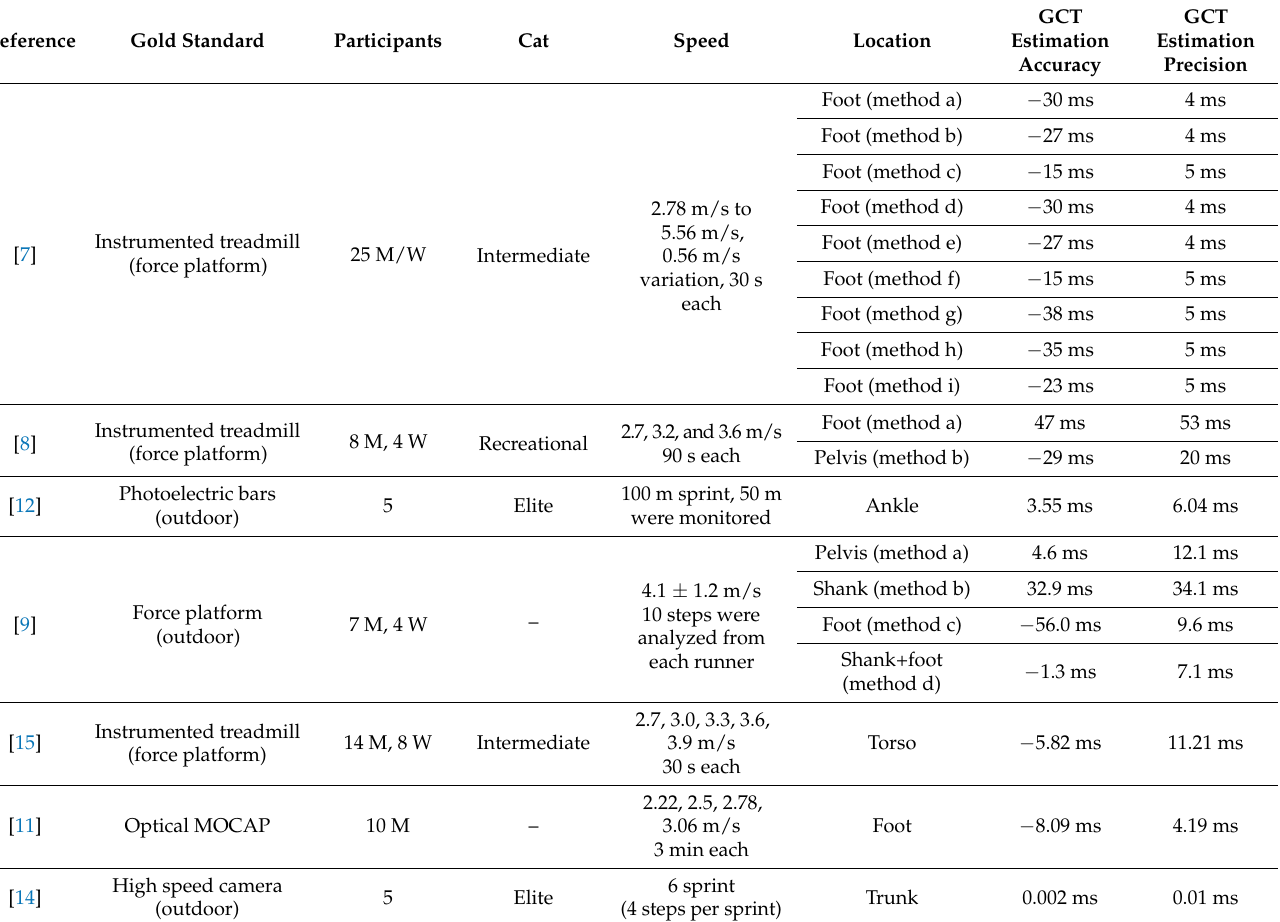
Table 1. Systematic search results. From left to right: reference, gold standard method used for validation of estimated GCT, number of participants (M: men, W: women), category of runners (recreational, elite, intermediate), speeds considered in the experiments, location of the sensor (different methods were addressed in some works from a single sensor), accuracy and precision of estimated